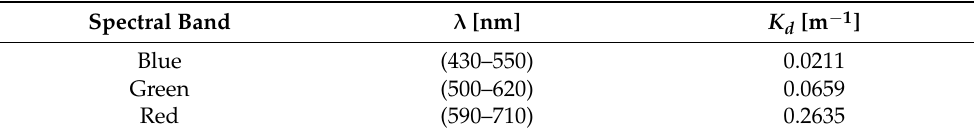
Table 2. Diffuse attenuation coefficient ( K d ) for every spectral band of Pleiades-1A sensor in the visible